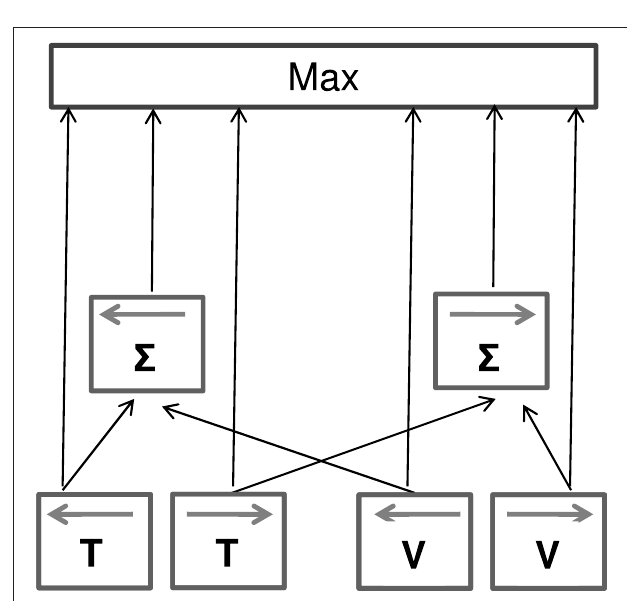
Figure 8 | Descriptive model for the interaction of visual and tactile motion signals. Visual and tactile motion signals interact at two levels: a low direction-specific sensory level and a higher decisional stage in which a probability interaction occurs. At the first level we assume the signals are vectorially summed (taking direction into account), while at the second level (upper box) we assume a simple maximum operation that chooses the largest signal for each trial. An important aspect of the model is that cross-modal summation is non-compulsory: signals both from the individual senses, and after combination arrive at the decision level. If the combination is less than the individual sensory signals, the maximum operation will choose the unisensory rather than multisensory signals. This schema explains, at least qualitatively, all the observed